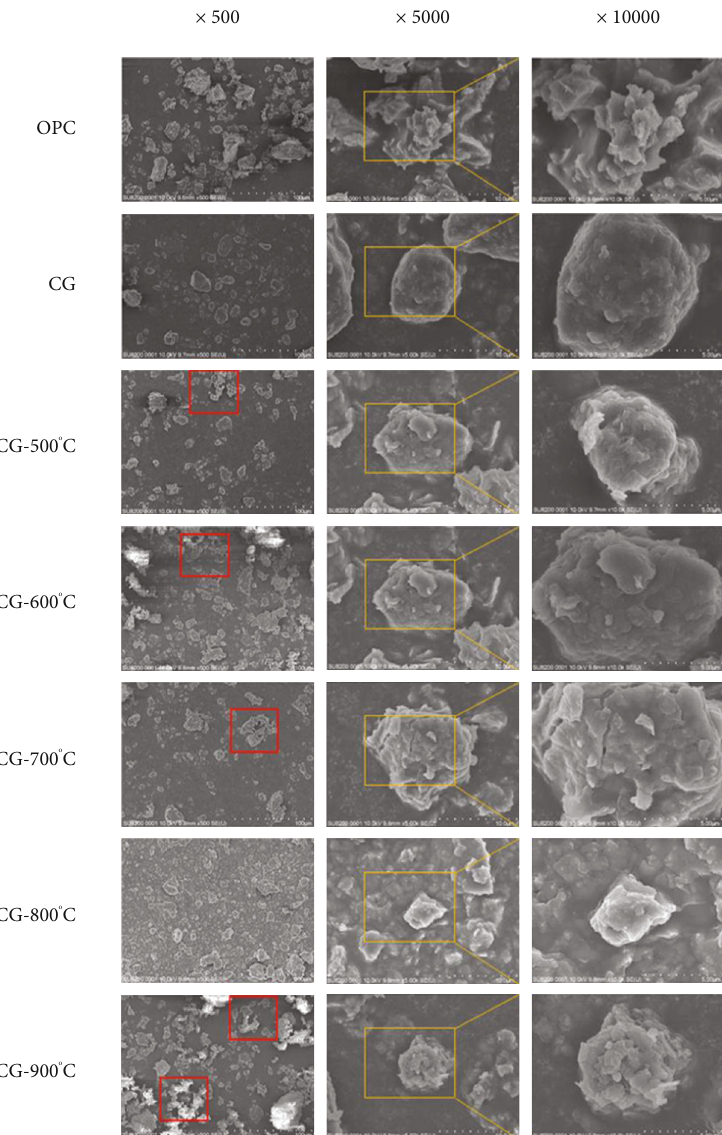
Figure 8: The micromorphology of OPC, CG, and thermally activated CG